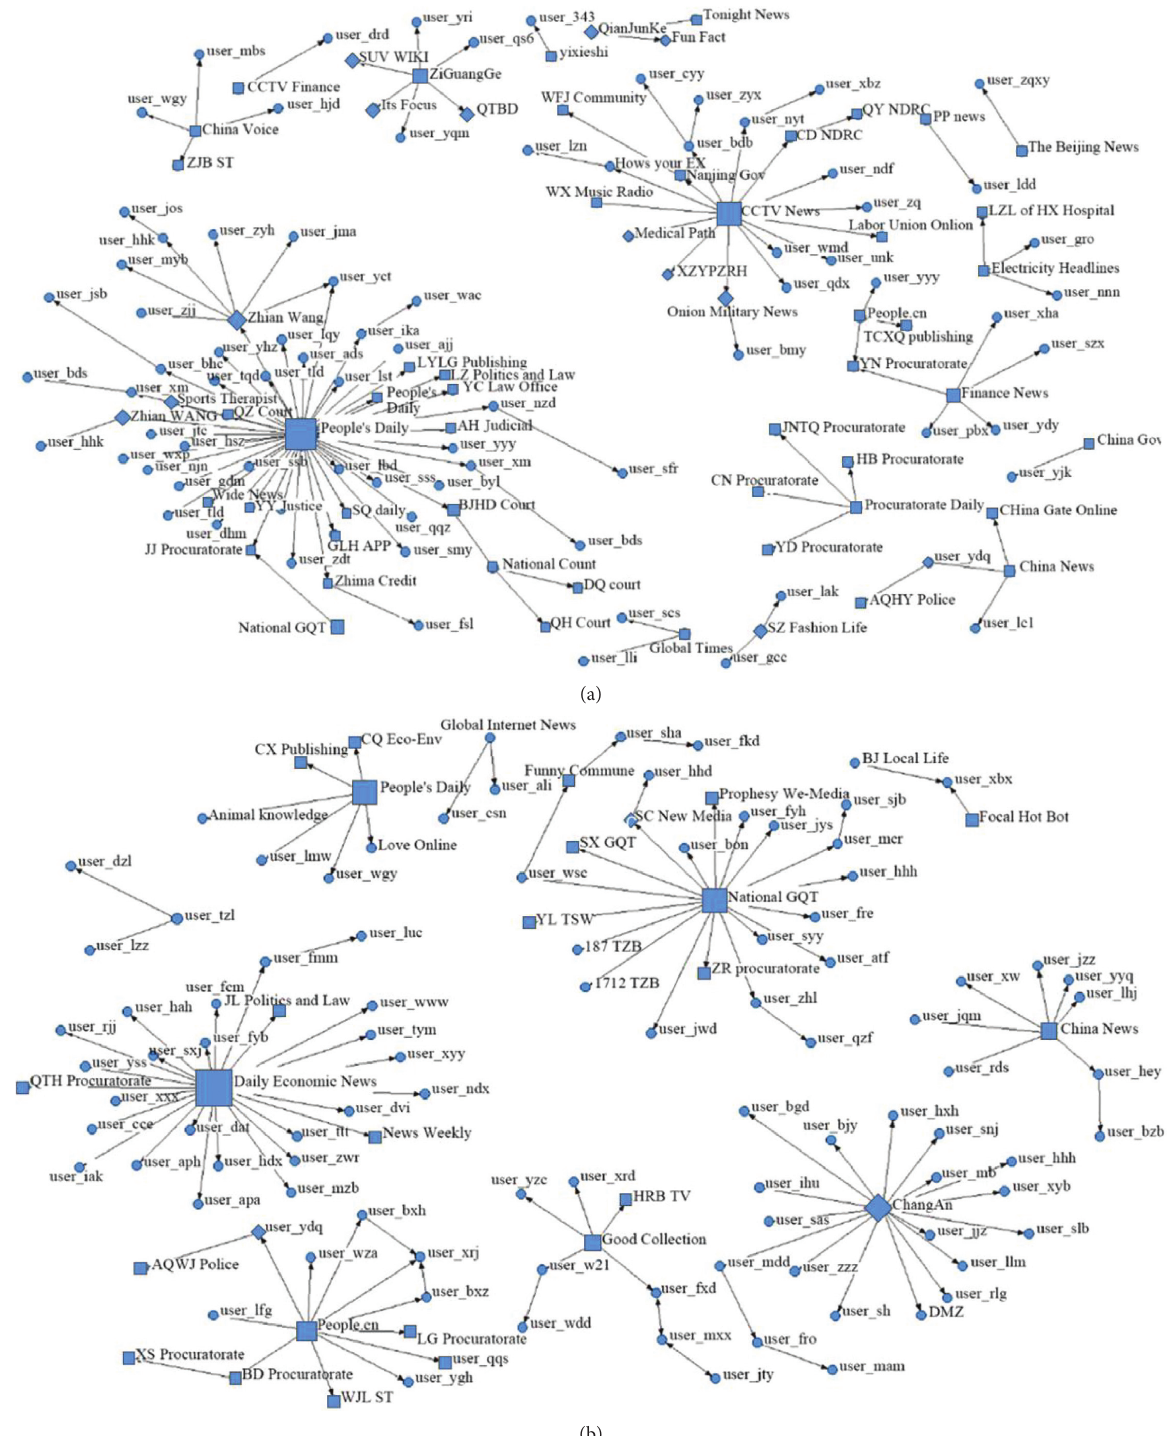
Figure 4: Simplified network mapping of (a) GCPN and (b)